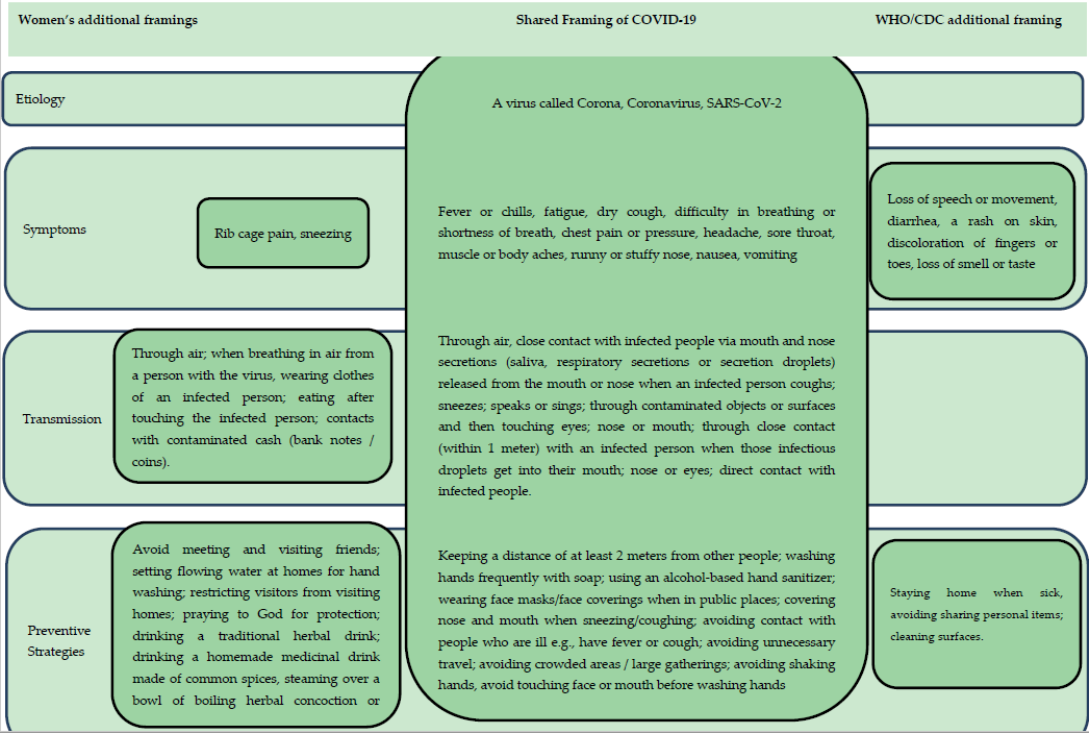
Figure 1. Women’s framing of COVID-19 vs. Biomedical frame.